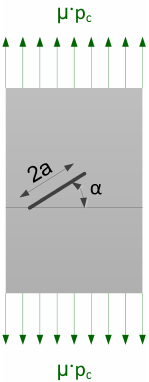
Figure 8. Direction of the orientation of angle α on the surface of the bearing